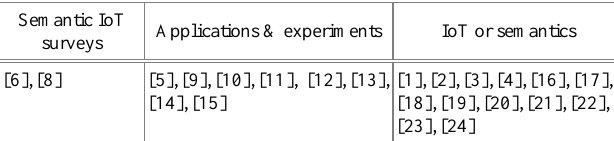
S URVEY P APER C OMPARISON BY THE C ONTEXT Semantic IoT